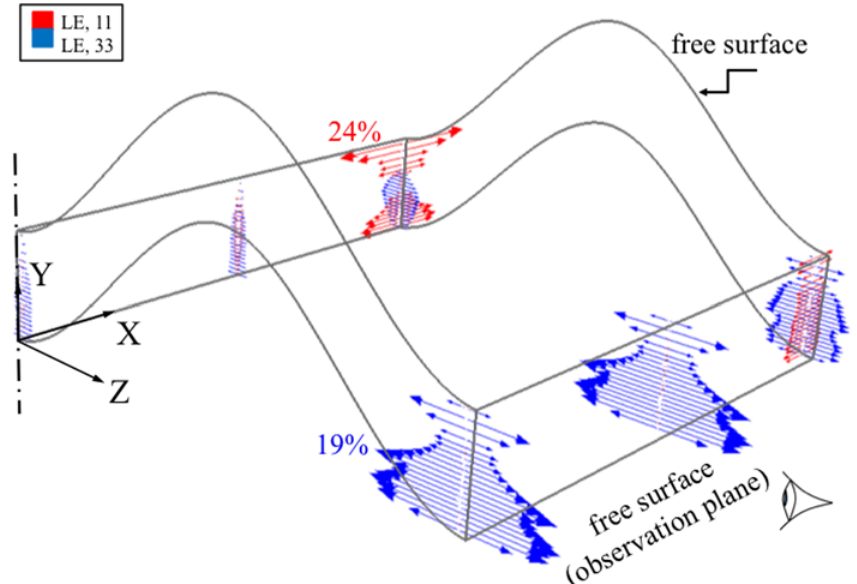
Fig 5. Logarithmic strain vector plots at the center and at a plane 50 μ m from one of the two free surfaces of the ‘ m ’ shape growth plate undergoing axial (Y-) compression of 20%. The red and blue arrows represent strains in X and Z directions, respectively, at the integration points. The results were obtained from the mesoscale model where detailed chondrons are not included. Regions close to the outer edge experienced a significant level of transverse (X- and Z-) strains. These strains suggest that observations made near the surface would lead to different assessment of transverse outward strain distribution compared to the interior of the growth plate. The centerline represents the center of the full model, as a quarter of the actual growth plate layer is shown here (XY and YZ planes are symmetry planes).